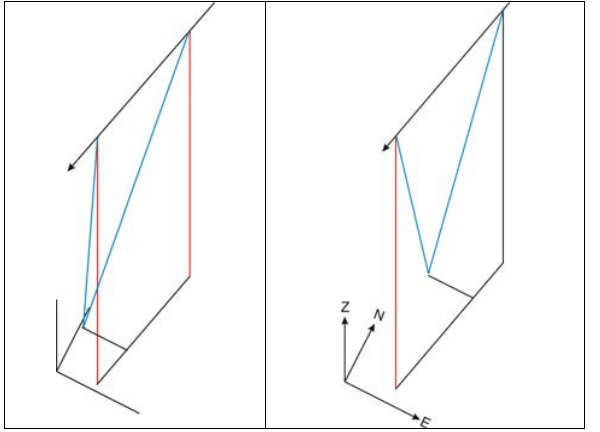
Figure 2: imaging constellation. Left: IKONOS, right: GeoEye- 1